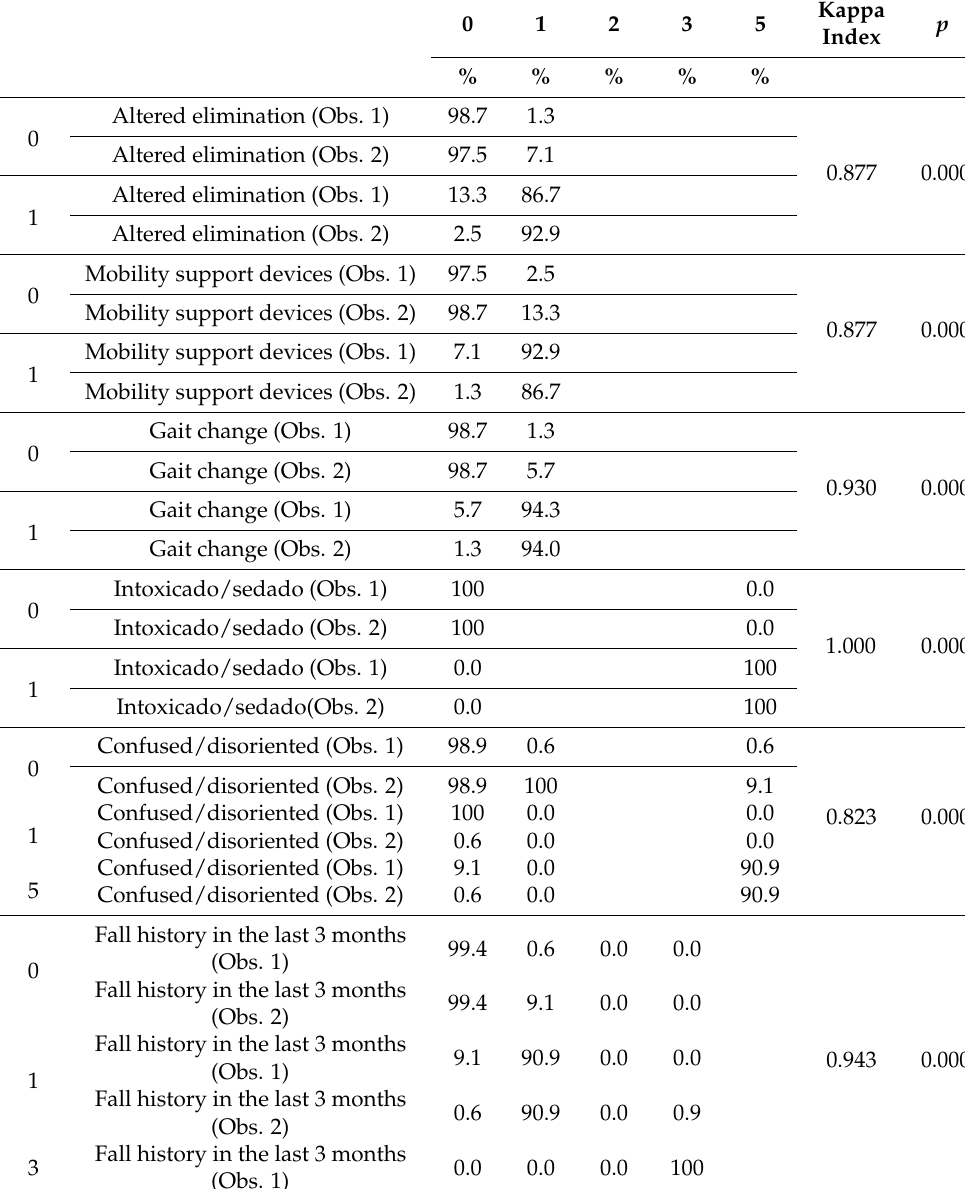
Table 3. Results of the level of agreement of the Kappa Coefficient between the two observers regarding the indicators of the